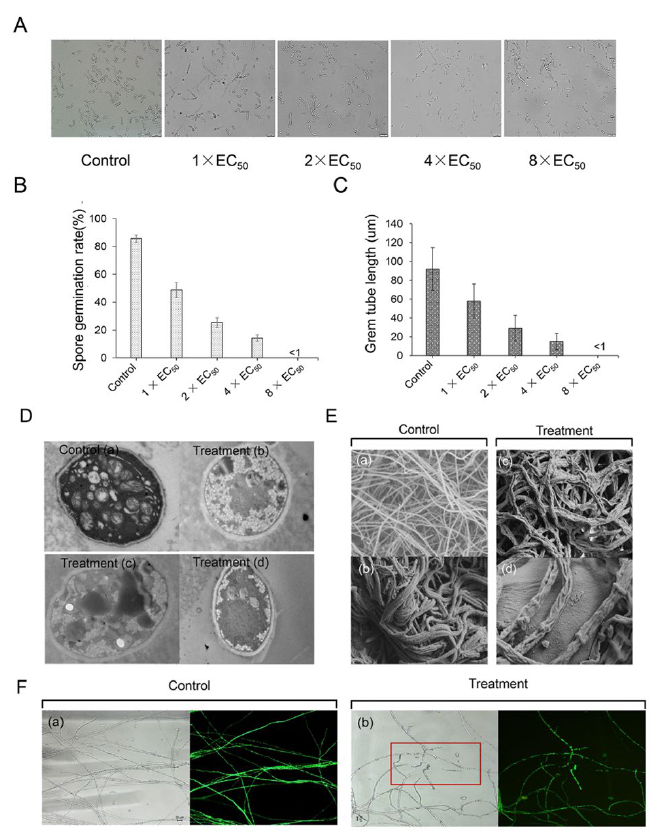
Figure 3. Inhibition of Streptomyces sp. Y1-14 extracts on spore germination of Foc TR4. ( A ) Spore germination characteristics of Foc TR4 after treatment with 1 × , 2 × , 4 × , or 8 × EC 50 extracts. A 10% concentration of DMSO was used as a control. Bar = 20 μm. ( B ) The spore germination rate (%) of Foc TR4 after treatment with different dose extracts. ( C ) The germ tube length (μm) of Foc TR4 after treatment with different dose extracts. ( D ) Mycelial cell ultrastructure of Foc TR4 observed under TEM. ( a ) Ultrastructure characteristics of Foc TR4. ( b – d ) Ultrastructure characteristics of Foc TR4 treated with 4 × EC 50 of Streptomyces sp. Y1-14 extracts. Bar = 2 μm. ( E ) Mycelial morphology of Foc TR4 observed under SEM. ( a , b ) Mycelial characteristics of Foc TR4 in the absence of stain Y1-14